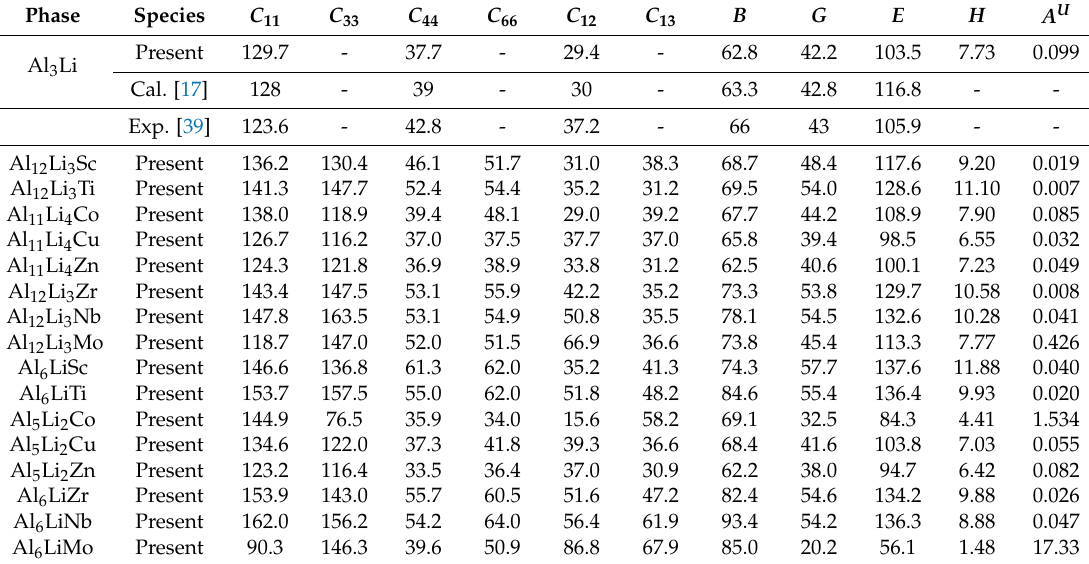
Table 3. Simulated elastic constants C ij (GPa), elastic moduli B , G , and E (GPa), hardness H